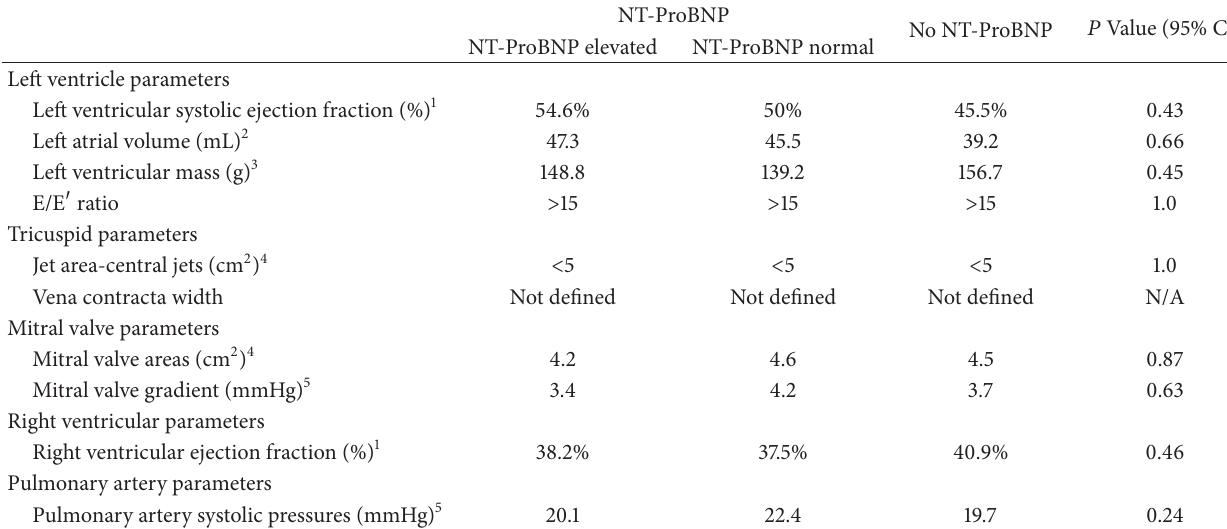
Table 4: The Echocardiography parameters of the NT-ProBNP elevated, NT-ProBNP normal, and no NT-ProBNP groups.